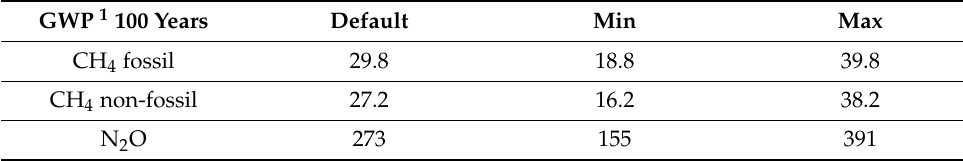
Table 2. IPCC AR6 CO 2 equivalency factors